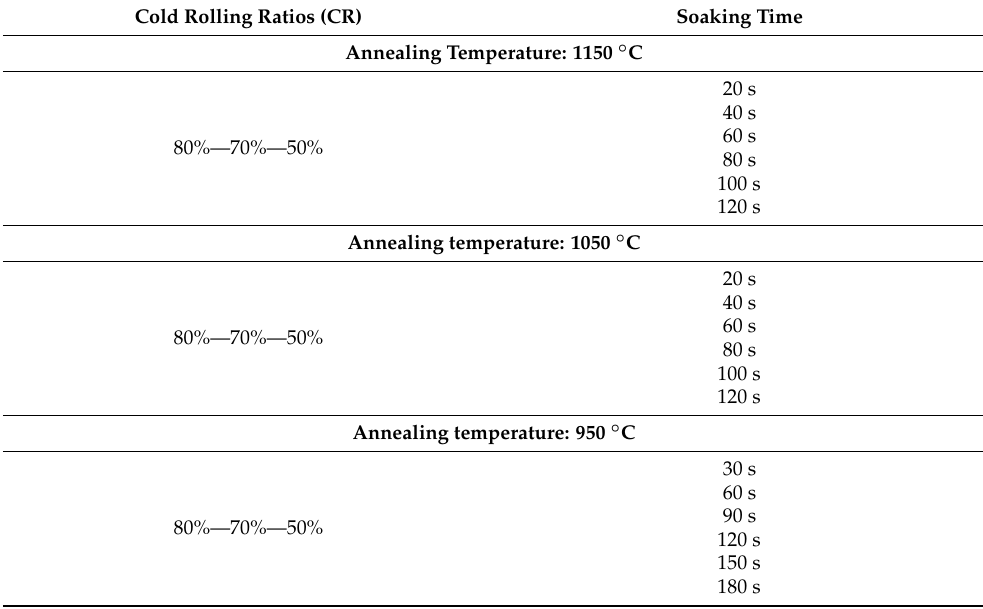
Table 2. Thermomechanical conditions of the considered